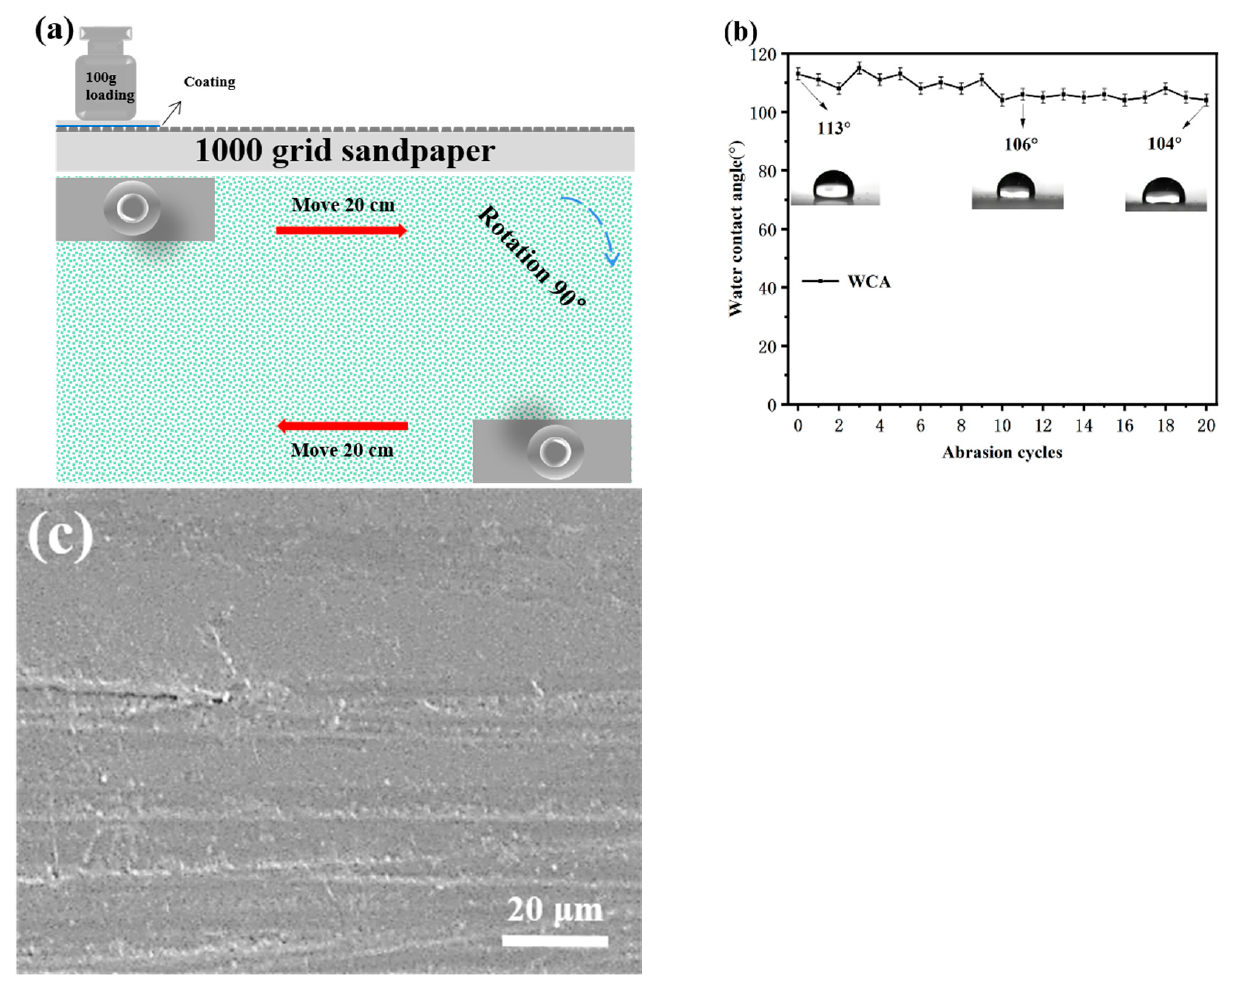
Figure 7. ( a ) Schematic diagram of sandpaper abrasion test, ( b ) variation in WCA with the number of sandpaper abrasion cycles, and ( c ) SEM images of the sample after sandpaper abrasion test.